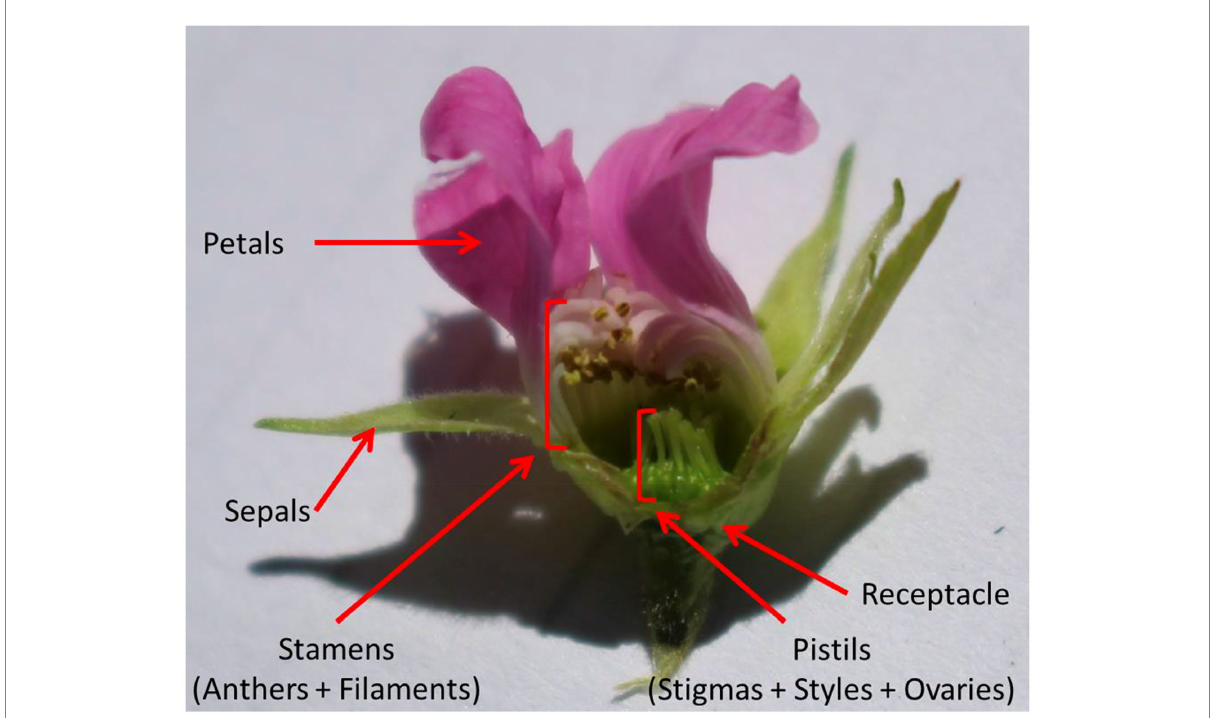
FIGURE 1 Longitudinal section of a Rubus arcticus flower showing restrictive morphology of